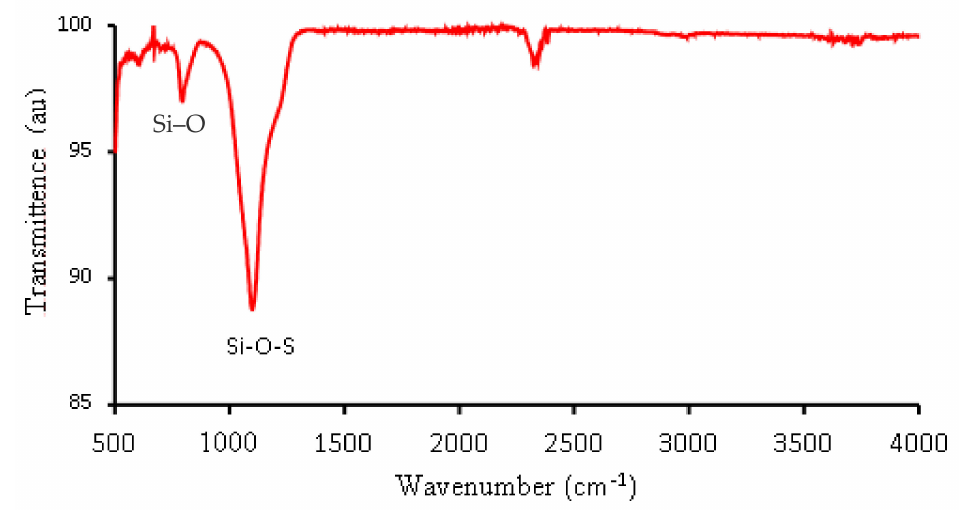
Figure 3. FTIR spectrum SSOD